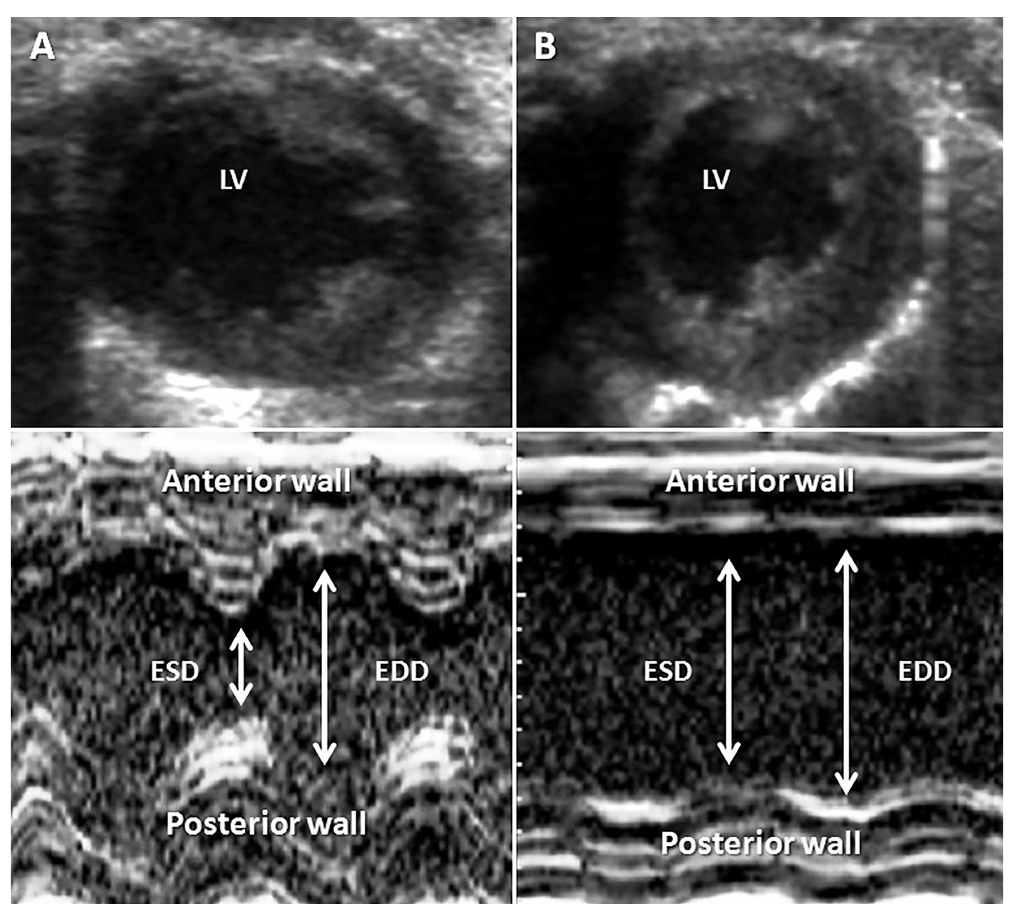
Figure 2 - Echocardiographic representation of Sham and AMI procedures. Panel A shows an animal’s heart with Sham surgery and panel B shows an animal with left coronary artery ligation. The top panel shows the left ventricle in a cross section and bottom panel shows stroke and end-diastolic dimen- sions of the left ventricle in M module. ESD: end-systole diameter; EDD: end-diastole